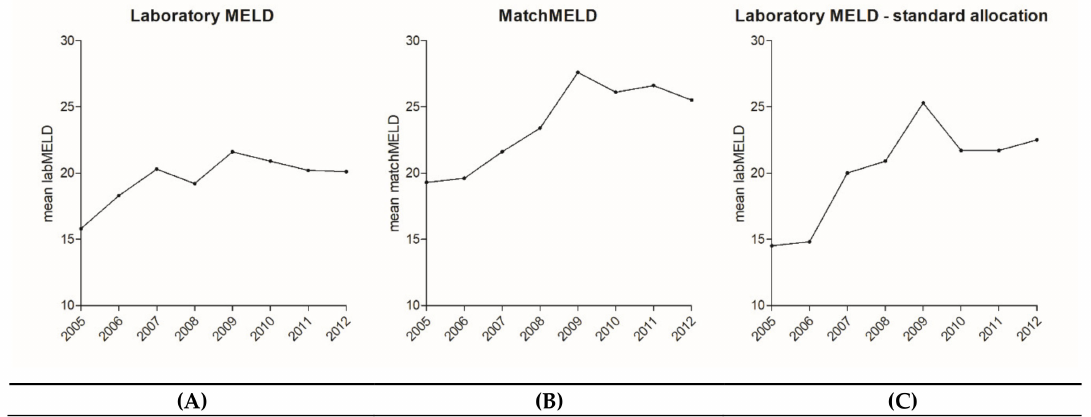
Figure 1. Development of MELD scores after the implementation of MELD-based liver allocation at our transplantation center. Laboratory MELD Score ( A ) as well as matchMELD score ( B ) and sub-analysis of patients without any prioritization (i.e., without patients with standard / non-standard exceptional MELD or high urgency status) ( C ) show a significant increase in the current allocation system after the implementation of MELD-based organ allocation (all p < 0.001). This indicates that patients became sicker at the time they received a donor organ over the years. MELD, Model for End-Stage Liver